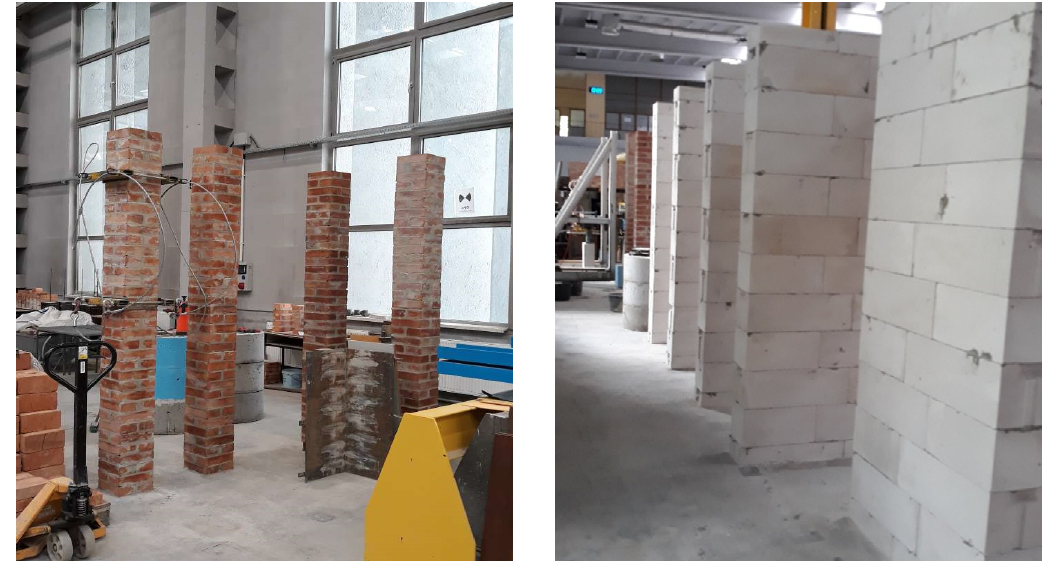
Figure 16. Photographs from the process of preparing models for research [23].